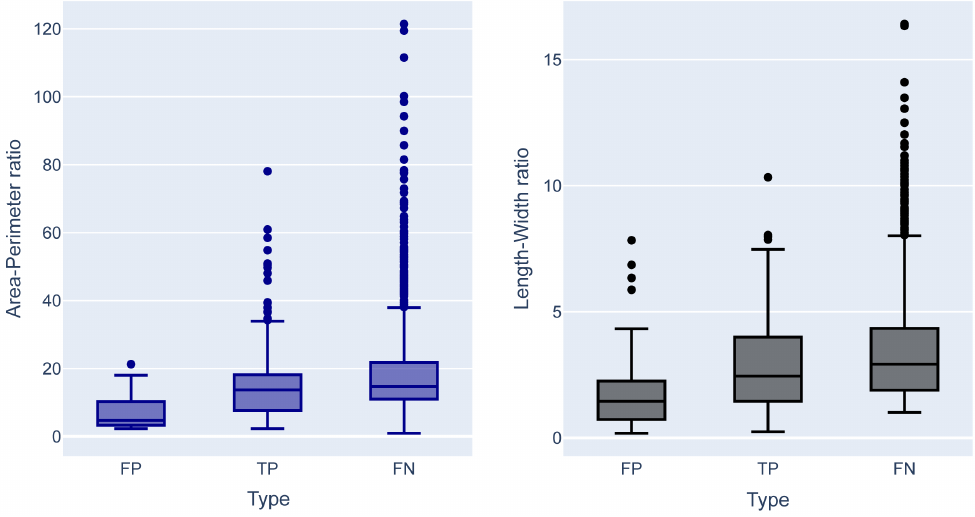
Figure 3. Exploratory analysis of the model results considering the geometry of landslides correctly and incorrectly detected by the algorithm.